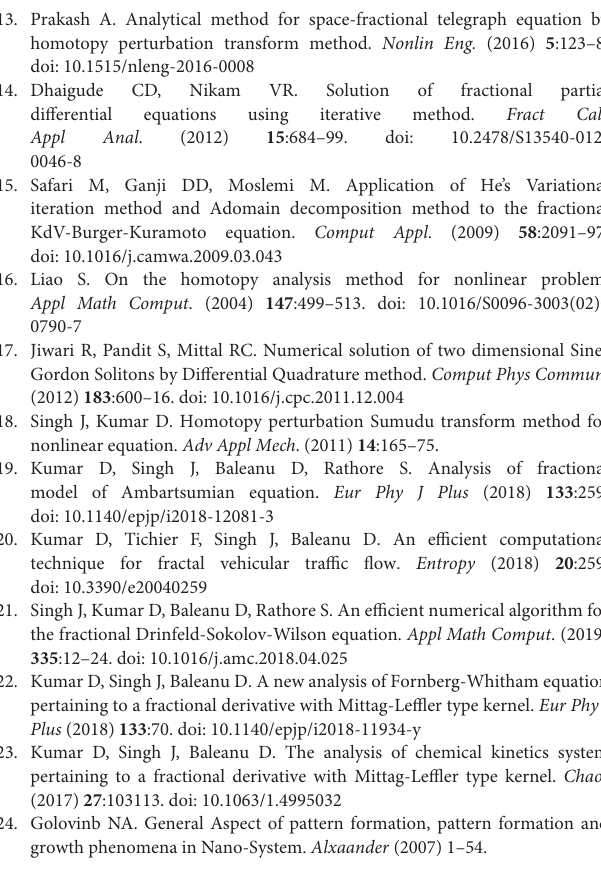
Figure 6 shows the comparison of third order approximate solution for different value of fractional order α 0.25, 0.50, 0.75, 1 and exact solution at α =